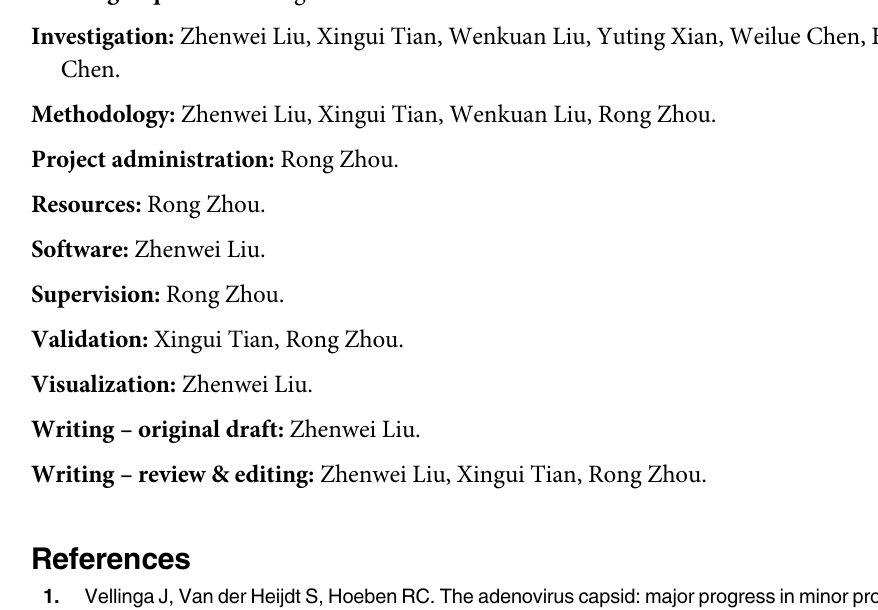
S1 Fig. Measurement of the neutralization of Fabs 2A6 and 4E2 by microneutralization assay. To measure neutralization, 165 μ L purified Fabs (0.2 mg/mL) were individually mixed with an equal volume of HAdV-E4 stock containing 200 TCID serum mixtures were incubated for 1 h at 37 ˚C in 5% CO tures were separately inoculated in triplicate onto 96-well plates containing a culture of A549 cell monolayers at 80% confluence. Two hours later, cells were washed thrice with DMEM/F- 12 and then maintained in DMEM/F-12 at 37 ˚C in 5% CO uninfected cells or virus were included. After 3 days, the cells were observed to evaluate the appearance of CPE. The cells were observed by a microscope (100 × ). Cell cultures with obvi- ous CPE were visualized in wells with either